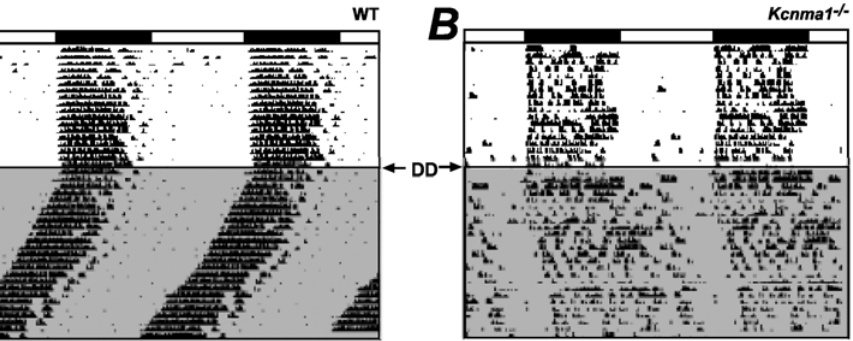
Figure 4. Representative wheel running rhythms from WT and Kcnma1 2 / 2 mice. Mice were housed on a standard 12 hr light: 12 hr dark cycle for 18 days (light and dark bars above actogram), and then placed in constant darkness (DD) for 25 days (shaded bottom part of actogram). Tick marks denote wheel running and actograms are double-plotted to emphasize the behavioral rhythm. A, The WT mouse has a circadian period of 23.5 hr in DD, and the x 2 circadian amplitude of the behavioral rhythm was 2390. B, Representative Kcnma1 2 / 2 actogram (period=24.2 hr and x 2 circadian amplitude=375).